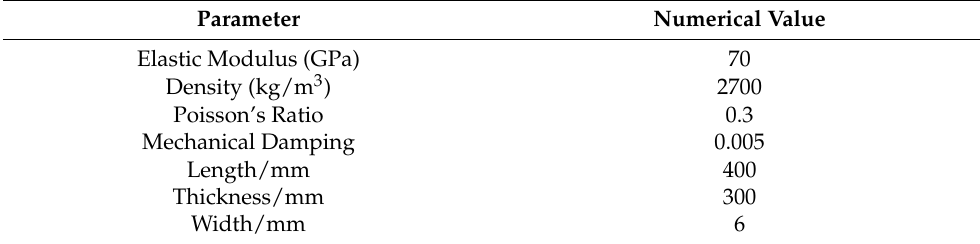
Figure 2. Rectangular plate with ABH structure. Table 1. Material properties and geometric parameters of the aluminum sheet.